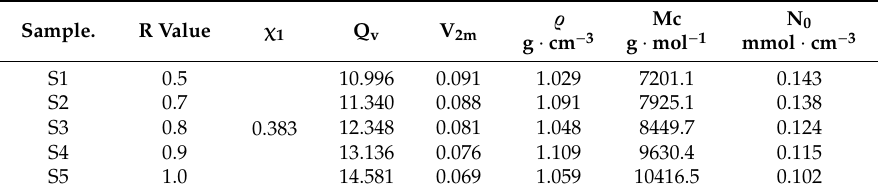
Table 2. Structural parameters of PTPET-based elastomers.